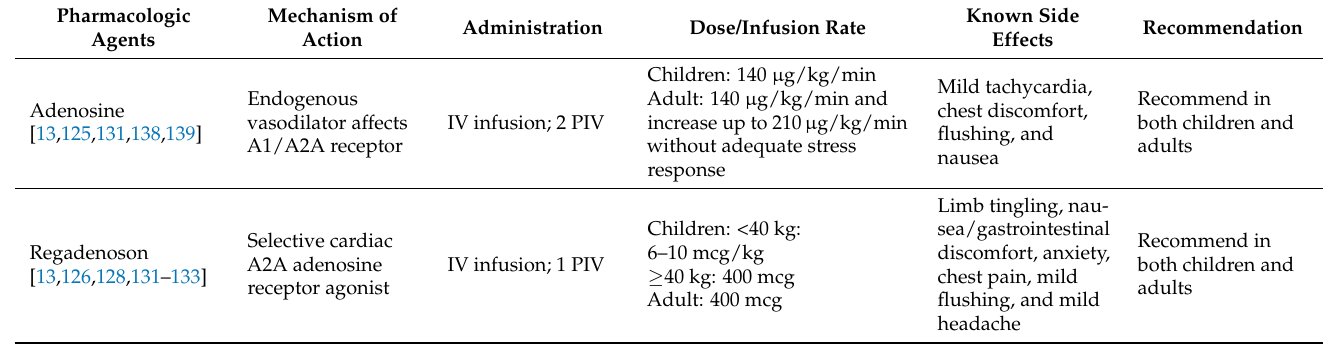
Table 2. Suggested stress CMR protocols with different pharmacological agents in children and